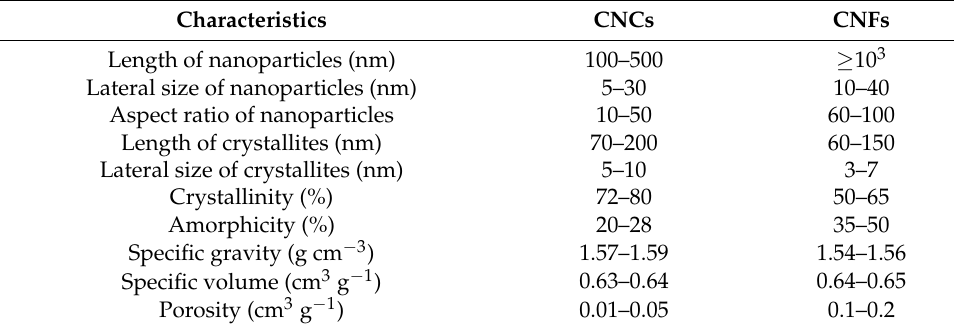
Table 1. Structural characteristics of cellulose nanocrystals and individual nanofibrils (CNC and CNF, respectively) [67]. Copyright 2017, Wiley books.